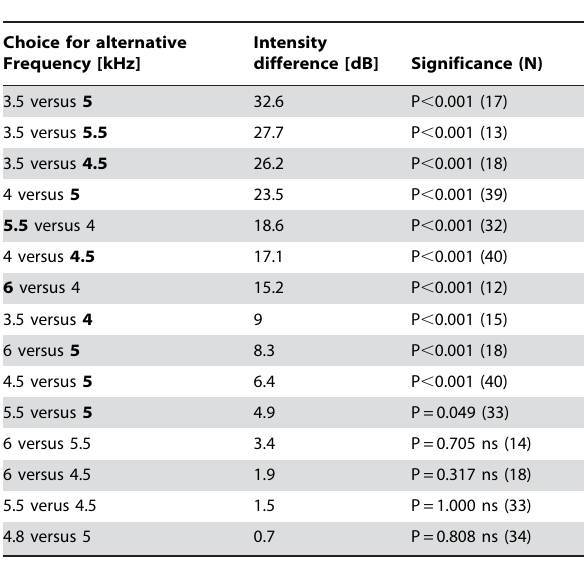
Table 1. Summary of results of two-choice-trials between song models differing in CF, in relation to the mean threshold difference of the AN1-neuron for the two involved frequencies, established in each individual female (preferred CF in bold; ‘‘z-test’’).